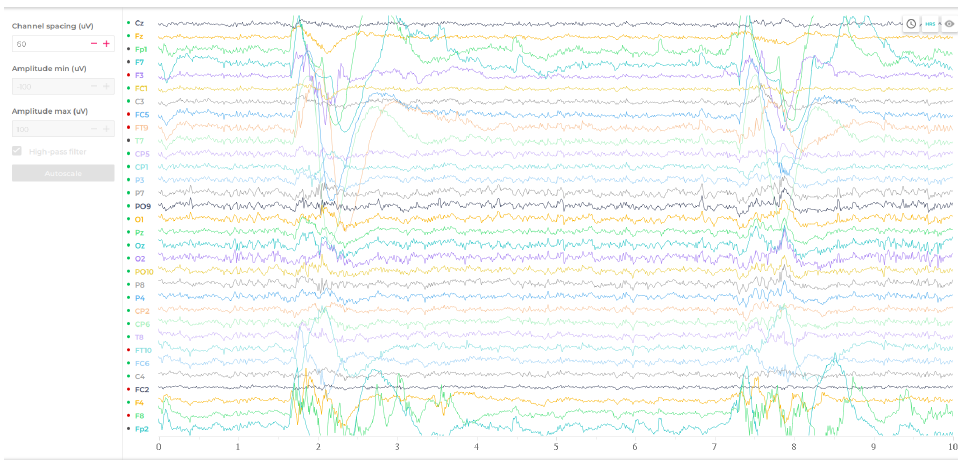
Figure 14. An example of a nervous blink